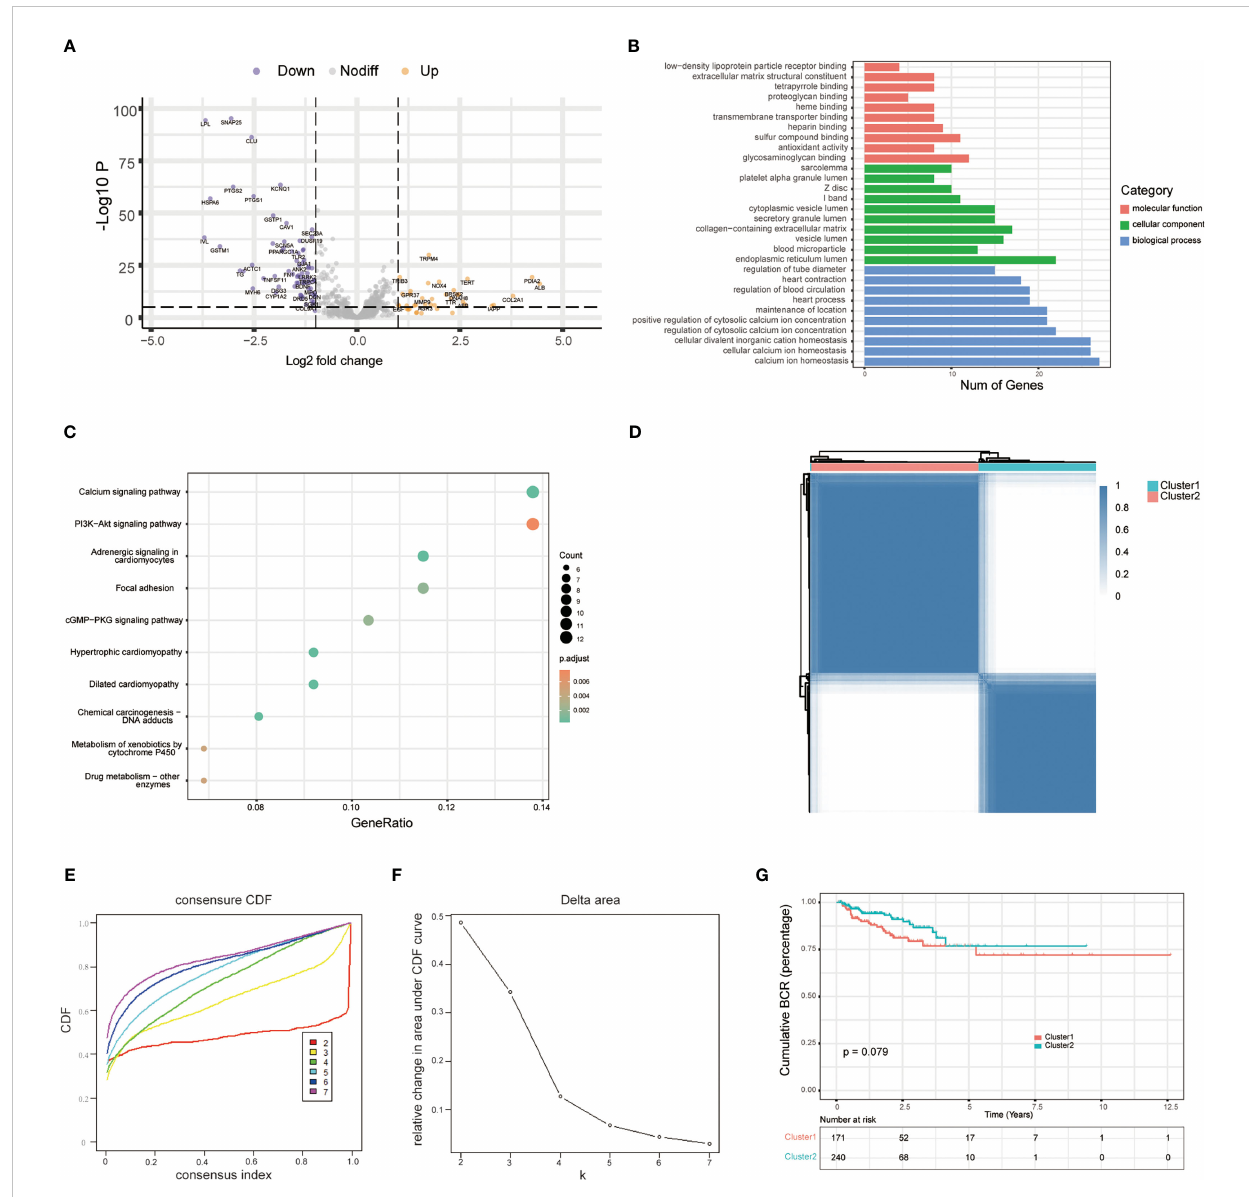
FIGURE 1 Exploration of endoplasmic reticulum stress-related genes. (A) Volcano plot shows differentially expressed endoplasmic reticulum stress-related genes between tumor and adjacent normal tissue in the TCGA database. (B) GO analysis terms of reticulum stress-related DEGs. (C) The top 10 most enriched KEGG pathways of ERS-related DEGs. (D) Consensus matrices of the TCGA-PRAD cohort for k = 2. (E) Consensus values range from 0 to 1. (F) The corresponding area under the cumulative distribution function (CDF) curve changes relatively as the number of clusters changes from k to k + 1. k ranges from 2 to 7, optimal k = 2. (G) Survival analysis of patients between cluster 1 and cluster